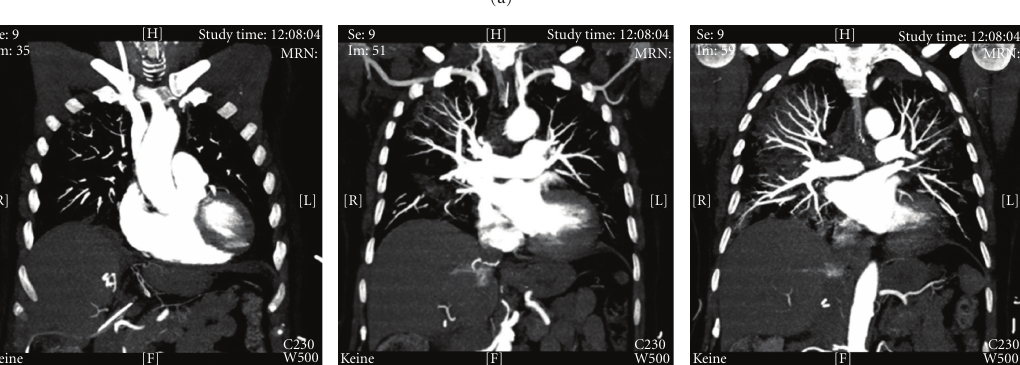
Figure 2: Coronary and axial cuts of the computed tomography of the chest immediately after the end of surgery before patient’s admission to the intensive care unit. d: